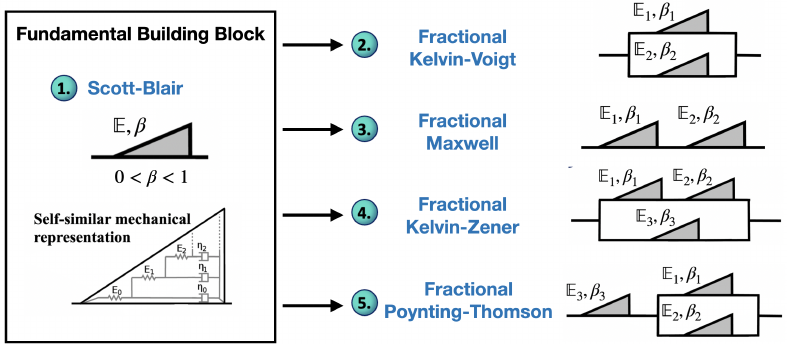
Figure 1. Fractional linear viscoelastic models employed in this work, constructed from se- rial/parallel combinations of “building block” SB elements. The SB building blocks naturally account for an infinite fractal arrangement of Hookean/Newtonian elements. The employed fractional quasi- linear model is not represented by a mechanical analogue although the time-dependent component of the relaxation function has an SB-like